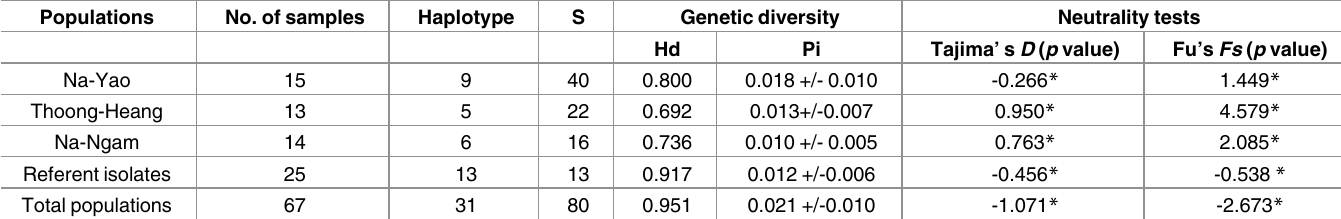
Table 3. The indicators of genetic diversity and neutrality tests in the populations of O . viverrini from three villages using nad1 sequences. Populations No. of